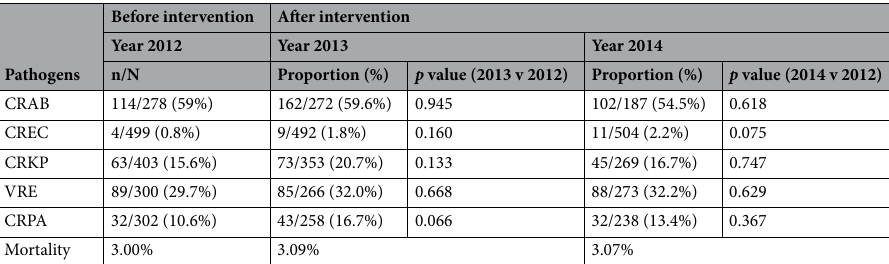
Table 2. The proportion of drug resistant pathogens in nosocomial infections. CRAB, carbapenem-resistant Acinetobacter baumannii ; CREC, carbapenem-resistant Escherichia coli ; CRKP, carbapenem-resistant Klebsiella pneumoniae ; VRE, vancomycin-resistant enterococci; CRPA, carbapenem-resistant Pseudomonas aeruginosa.